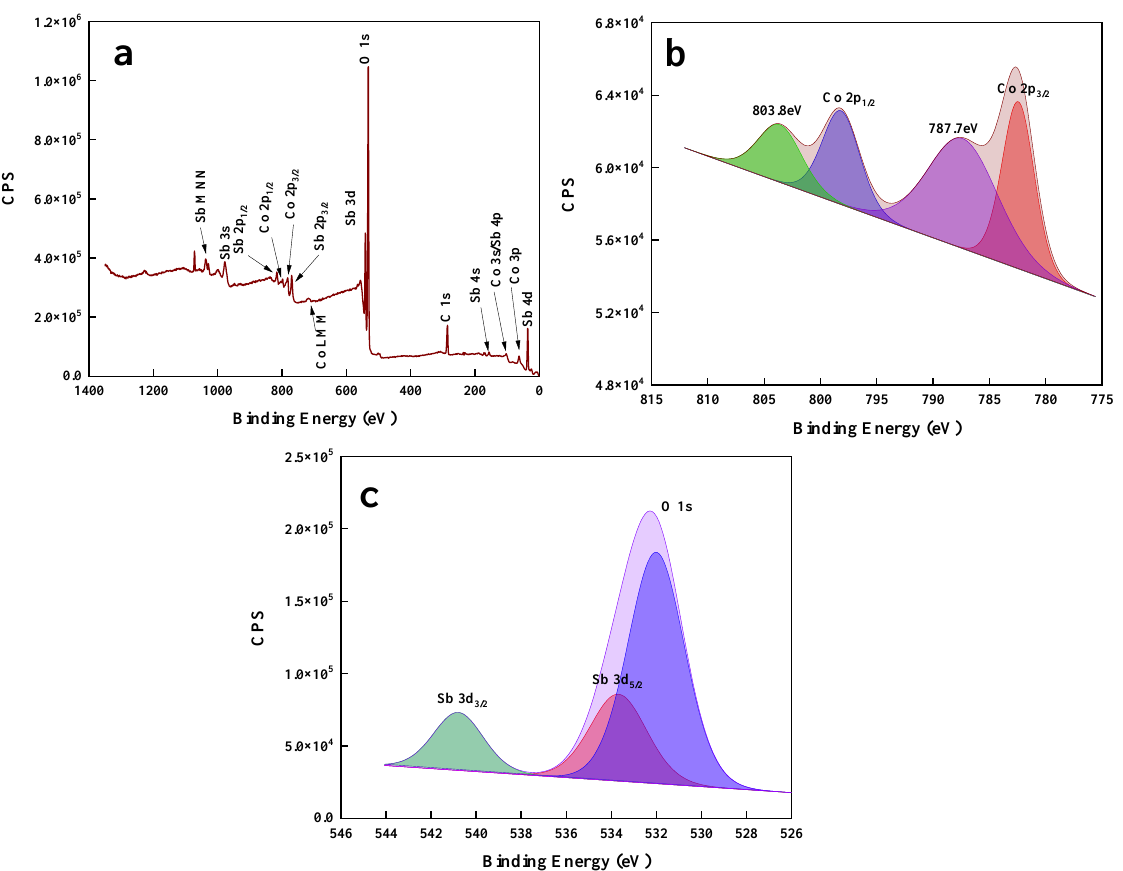
Figure 7. The wide scan XPS of CSO ( a ); the high-resolution XPS spectra of Co2p ( b ) (the green and purple area represented the satellite peaks of Co2p 1/2 and Co2p 3/2 , the blue and red area represented the main peak of Co2p 1/2 and Co2p 3/2 ; the high-resolution XPS spectra of O1s/Sb3d ( c ) (the light green, light red and light blue area represented the main peak of Sb 3d 3/2 , Sb 3d 5/2 and O1s)